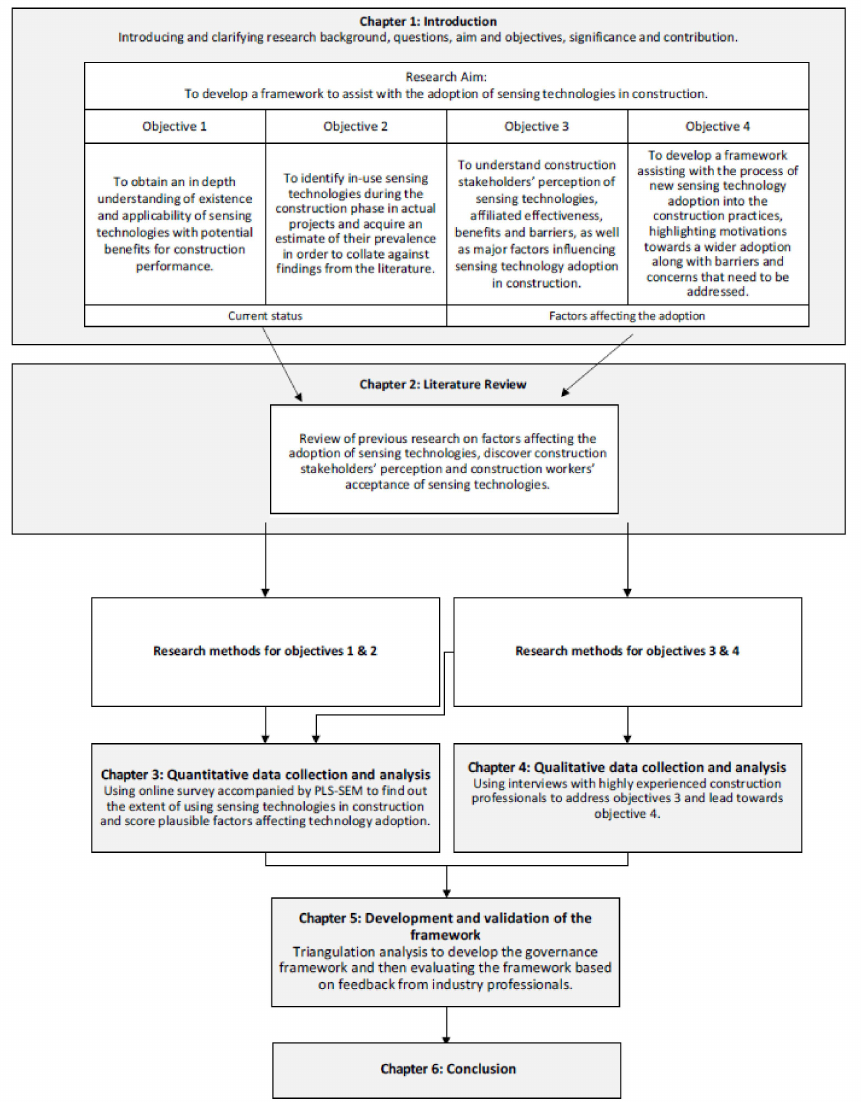
Figure 1. Structure of the